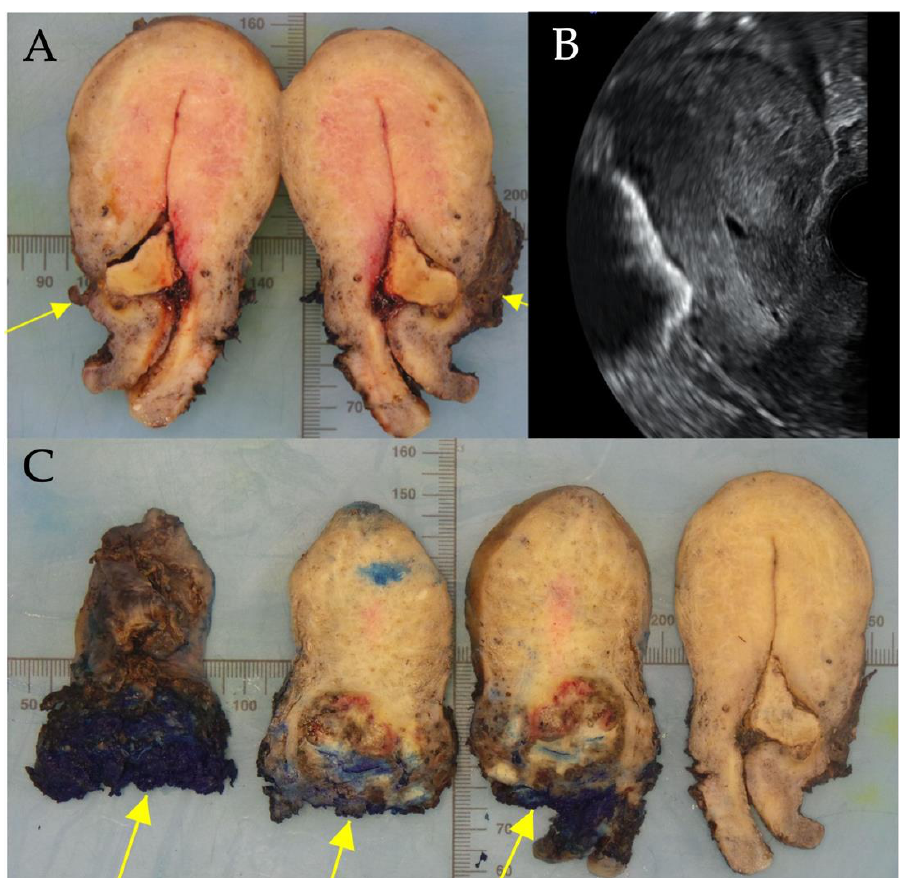
Figure 6. ( A ) Vertically transected hysterectomy specimen with trophoblast in the uterine niche measuring 20 × 15 mm 2 . ( B ) B-mode sagittal view of the uterus correlating with 6A. ( C ) Hysterectomy specimen with a blue inked appearance illustrating perforation of the left uterine isthmus by trophoblast measuring 56 × 44 mm 2 . Photograph by Dr. Maria Rosario Oliviera Diz.